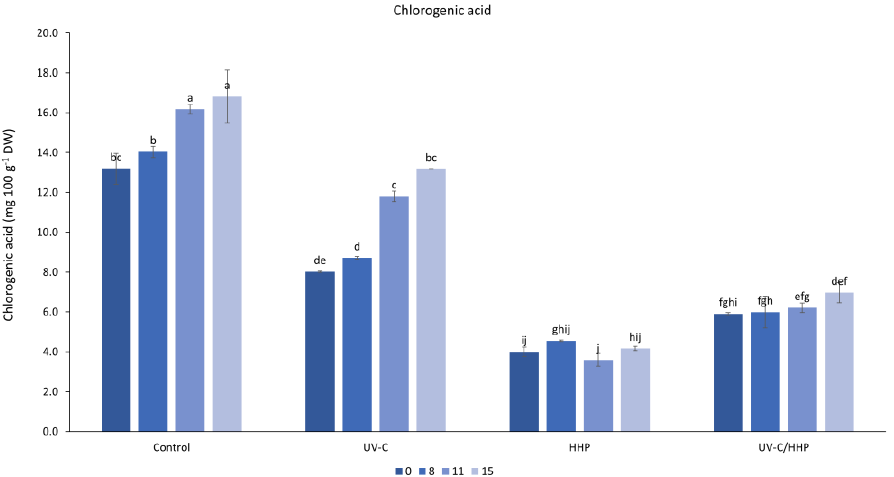
Figure 2. Interaction of treatment (control, UV-C, HHP, and UV-C/HHP) and storage time on chlorogenic acid content. Error bars represent standard errors; lowercase letters represent a significant difference within means ( p < 0.05).